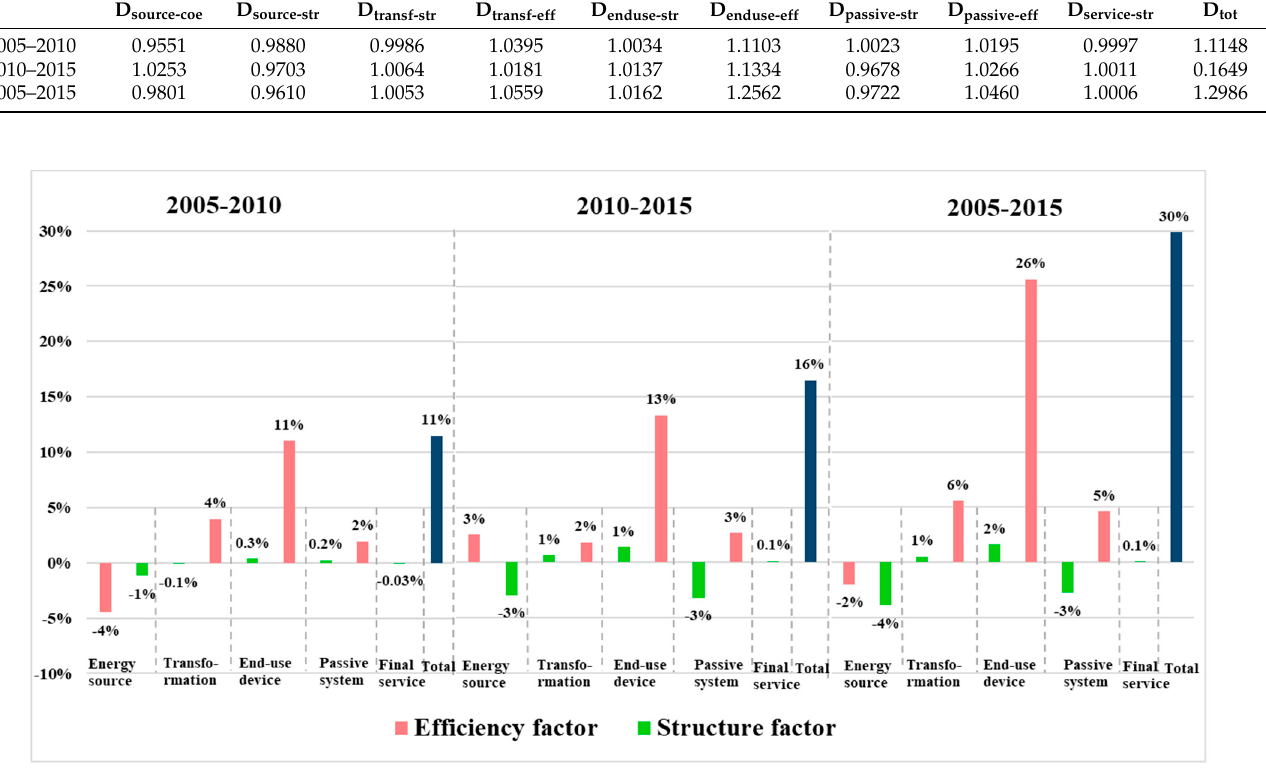
Figure 8. Relative contributions of the efficiency and structure factors of each stage in China from 2005 to 2015. (Note: Horizontal axis-different energy stages of energy system; Vertical axis-Relative contributions of different efficiency and structure factors on the aggregate exergy efficiency).